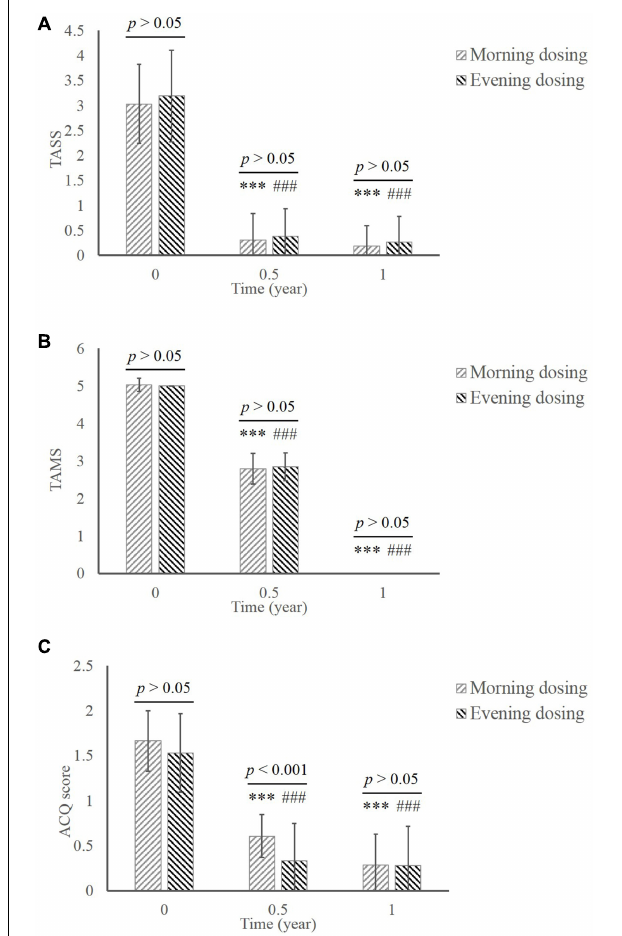
FIGURE 2 | The comparison of clinical efficacy between the MD group and the ED group. (A) TASS. (B) TAMS. (C) ACQ. ∗∗∗ , p < 0.001, significant difference in the MD group compared to baseline; ### , p < 0.001, significant difference in the ED group compared to baseline. MD, morning dosing; ED, evening dosing; TASS, total asthma symptom score; TAMS, total asthma medicine score; ACQ, Asthma Control